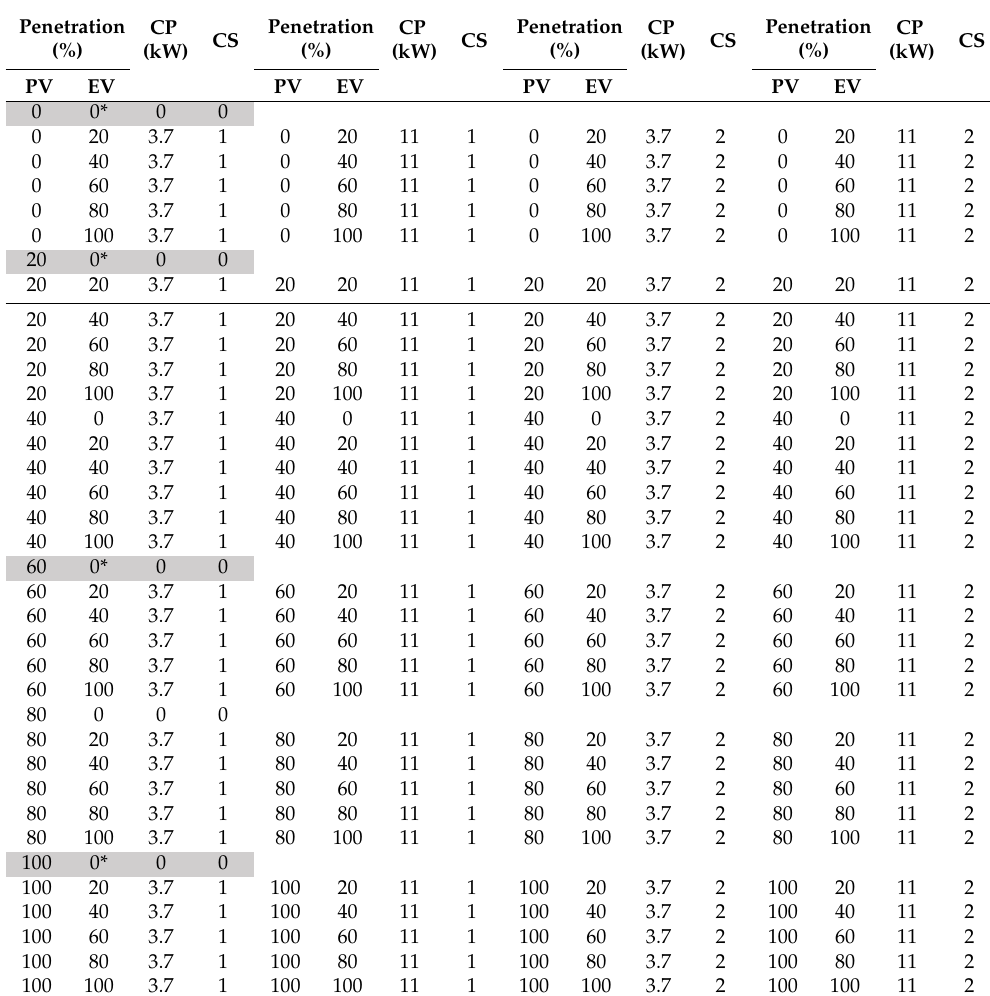
Table A1. Overview of all simulated scenarios during the presented case